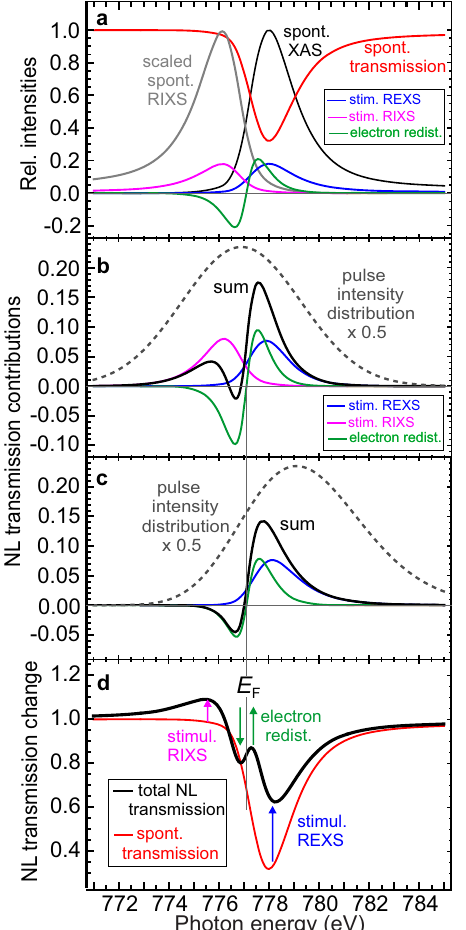
Fig. 3 Model of nonlinear X-ray spectra. Here, spont. stands for spontaneous, stim./stimul. stand for stimulated, redist. stands for redistribution, rel. stands for relative, NL stands for nonlinear and E F is the Fermi energy. a Model Co L 3 spontaneous Resonant Inelastic X-ray Scattering (RIXS, gray), X-Ray Absorption Spectrum (XAS, black) and transmission (red) spectra, and three assumed non-linear contributions, stimulated RIXS (magenta), electron redistribution (green) and stimulated Resonant Elastic X-ray Scattering (REXS, blue). The sizes of the nonlinear contributions are referenced to the unit value of the XAS peak. b Assumed incident pulse reference distribution (dashed), which allows all three nonlinear channels to contribute to the sum shown in black. c Shifted pulse reference distribution (dashed) which eliminates the stimulated RIXS contribution. The remaining two add up the sum shown in black. d Change of the spontaneous transmission spectrum (red) taken from ( a ), to the total nonlinear transmission one (black) for a wide incident energy distribution. The black curve is the red curve plus the the sum of all three nonlinear contributions. Colored arrows indicate nonlinear transmission gain (up arrows) and loss (down arrows) caused by the respective nonlinear